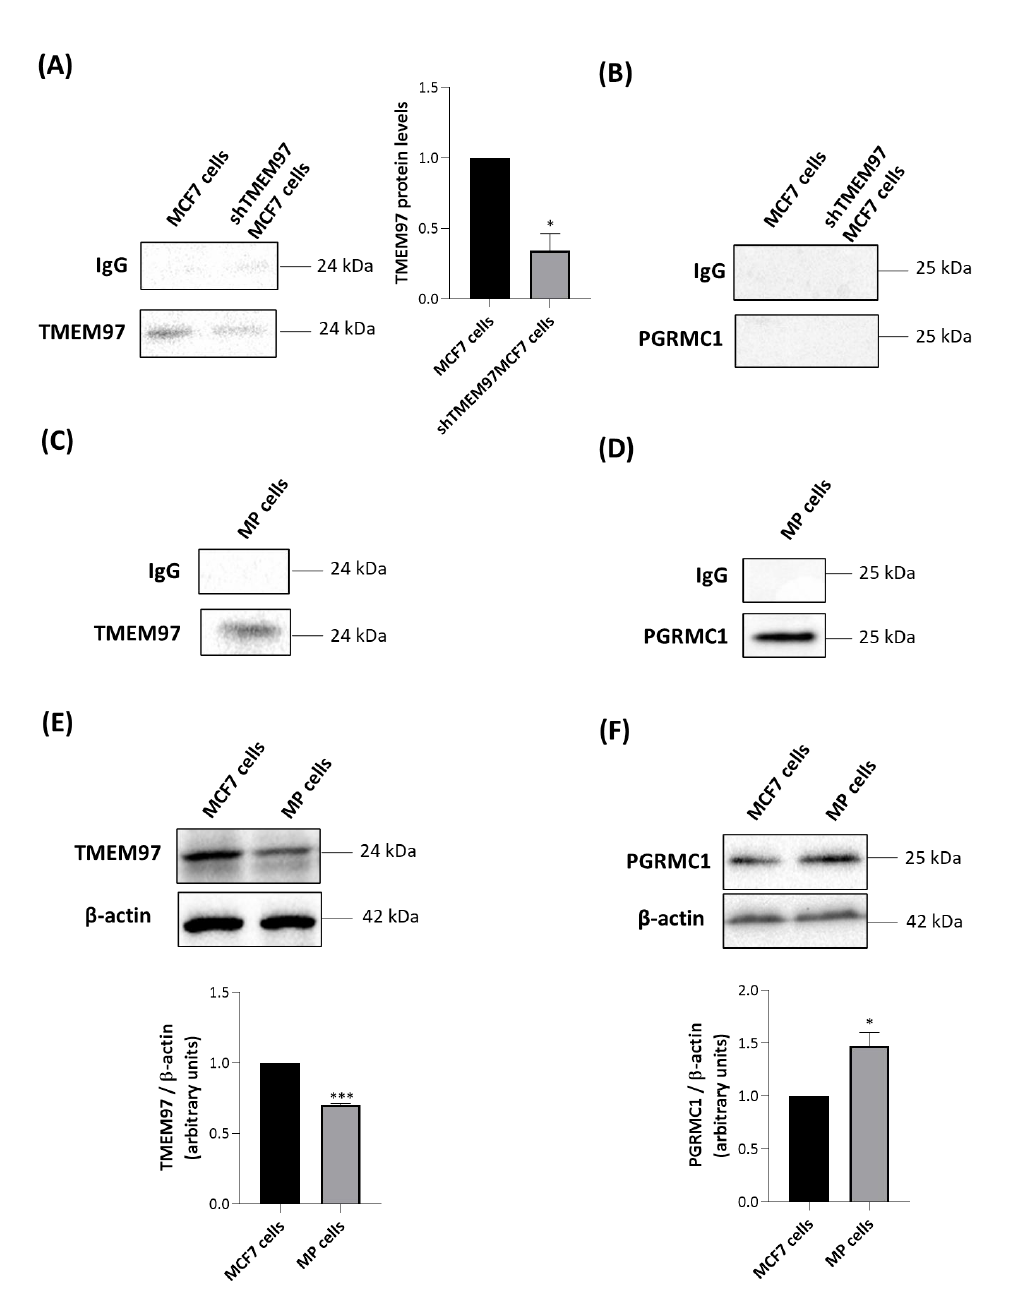
Figure 4. TSPO co-immunoprecipitates only with TMEM97 in MCF7 cells and with both TMEM97 and PGRMC1 in MP cells. MCF7 and shTMEM97MCF7 cells were immunoprecipitated with an antibody directed against TSPO and analyzed by Western blot with anti-TMEM97 ( A ) or anti-PGRMC1 ( B ) antibodies. TMEM97 protein levels in shTMEM97MCF7 cells were normalized versus proteins in MCF7 cells. MP cells were immunoprecipitated with an antibody directed to TSPO and analyzed by Western blot with anti-TMEM97 ( C ) or anti-PGRMC1 ( D ) antibodies. IgG is the negative control. Western blot analyses were performed to evaluate the protein levels of TMEM97 ( E ) and PGRMC1 ( F ) in MCF7 MP cells. In ( E , F ) protein levels were normalized against β -actin. Western blotting data are representative of at least three independent experiments. Graph bars were used to represent the means ± SD (error bars). Statistical significance of the differences was evaluated by using Student’s t -test (* p < 0.05, *** p <